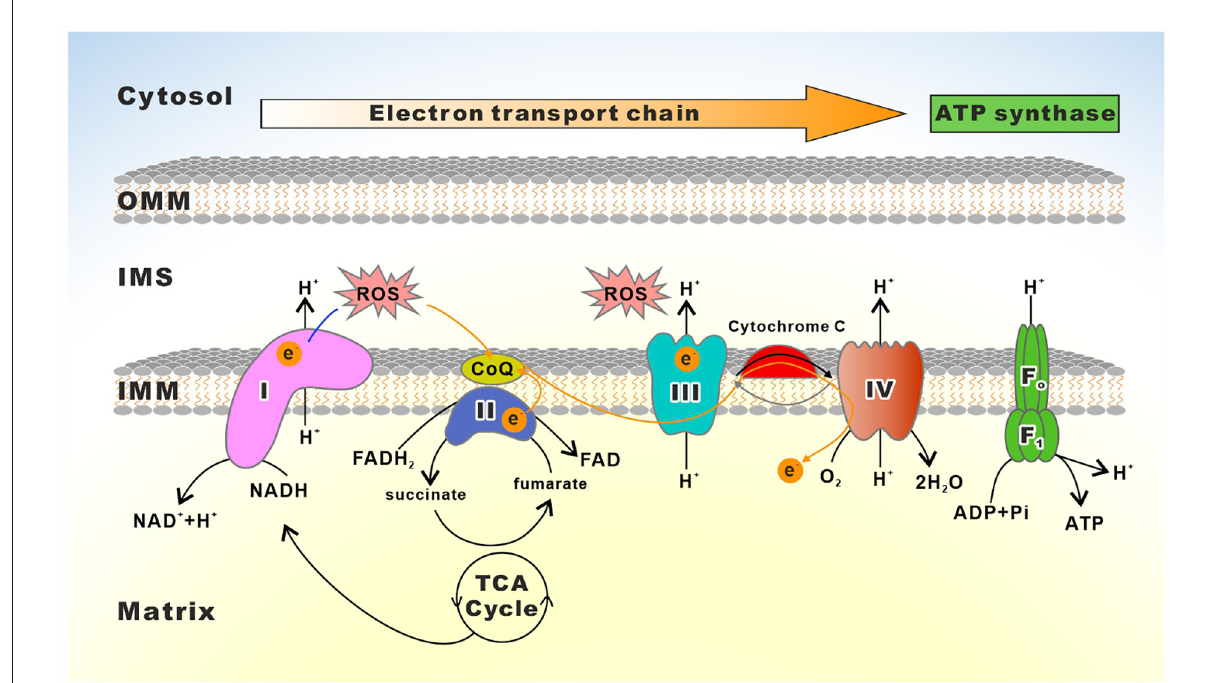
FIGURE2 Schematic depiction of the mitochondrial electron transport chain. The electron transport chain (ETC) consists of complexes I to IV as well as two free electron carriers, CoQ and Cyt c . Reducing equivalents (NADH, FADH2) provide electrons flowing through complexes I, the ubiquinone cycle (Q/QH2), III, IV, and to the final acceptor O 2 . The electron flows through complexes resulting in the pumping of protons to the IMS, which creates a membrane potential used by the F 1 F o -ATP synthase to drive the production of